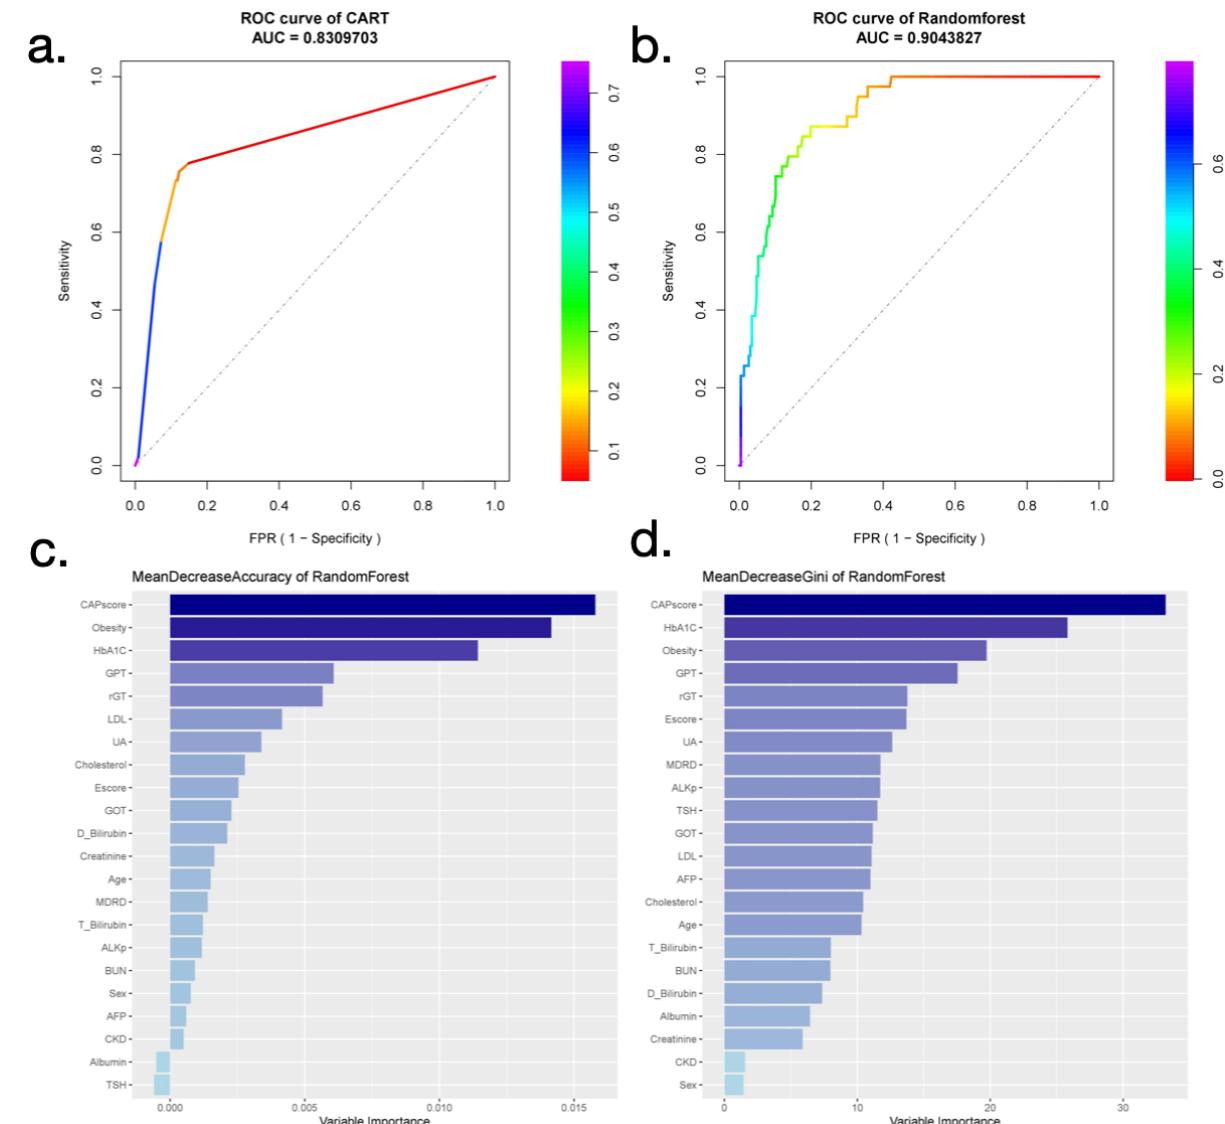
Figure 4. Random forest model for predicting classification performance and variable importance. Receiver operating characteristic (ROC) curve with area under the curve values for (a) classification and regression tree and (b) random forest. The color bar indicates the value of specificity in the false positive rate. (c) Variable importance ordered by accuracy of a mean decrease in random forest. (d) Variable importance ordered by the gini index of a mean decrease in random forest. The leading variables obtained by random forest are listed in darker blue, and less important variables are in lighter